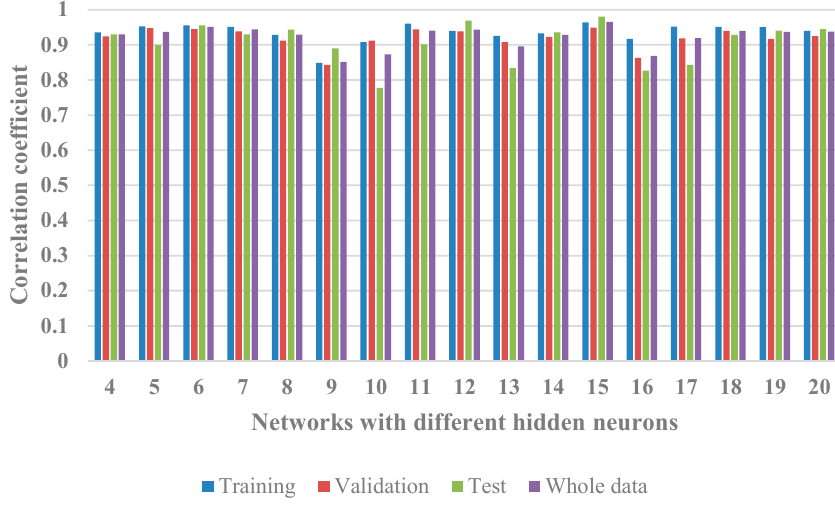
Figure 4. The correlation coefficient with different values of ANN 6: n :1.